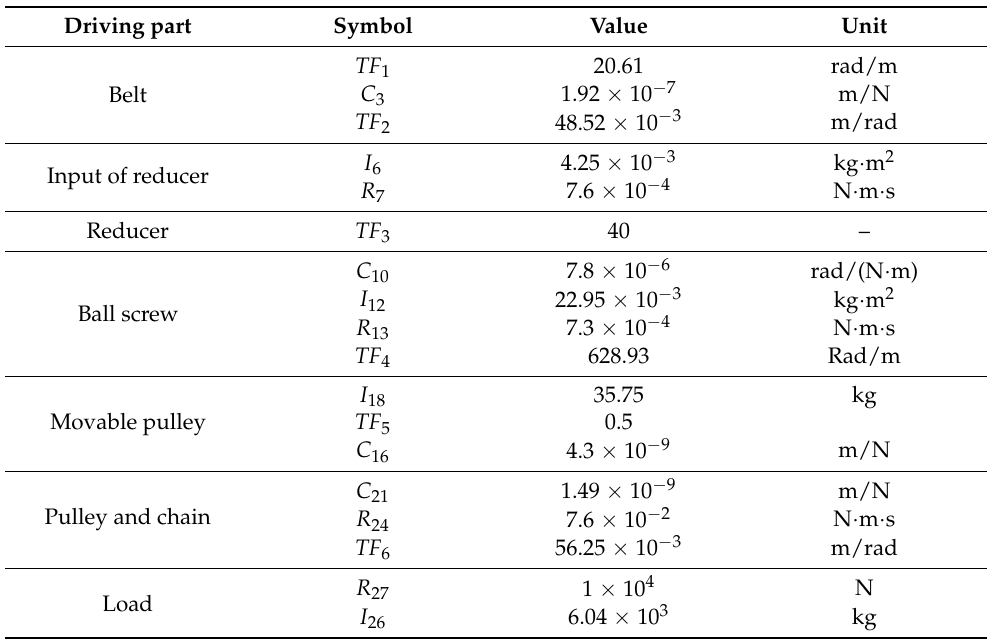
Table 3. The system parameters of ETD. Driving